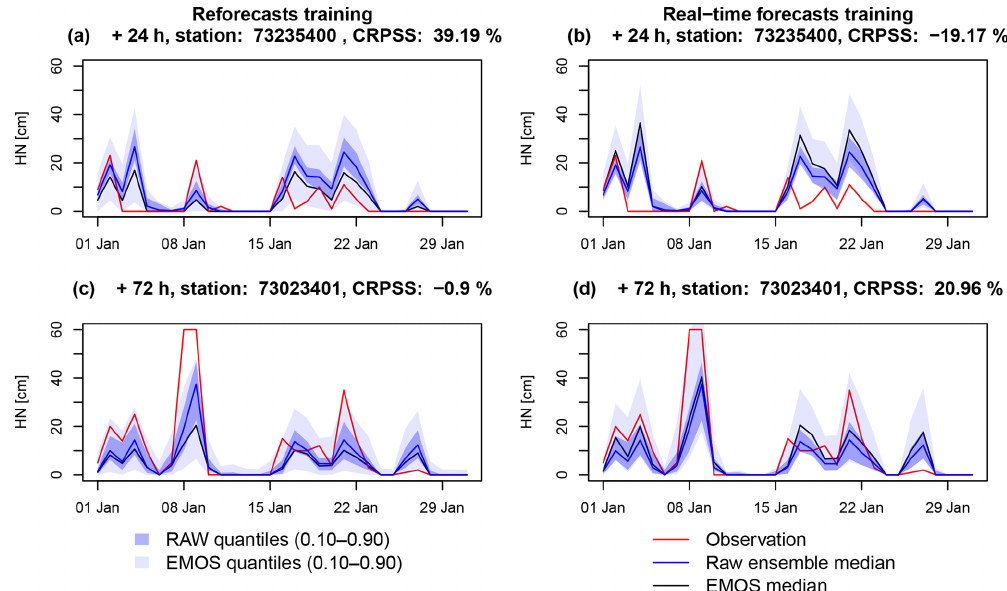
Figure 7. Time series of the raw (blue) and post-processed (grey) ensemble forecasts during January 2018 from a massif-scale training. The envelopes represent the interval between the 10th and 90th percentiles and the solid lines represent the median. These ensemble forecasts are compared to time series of HN observations (red lines). (a, b) Example of station 73235400 (Saint-François-Longchamp) at the + 24h lead time. (c, d) Example of station 73023401 (Aussois) at the + 72h lead time. (a, c) Training with the snow reforecasts. (b, d) Training with the snow real-time